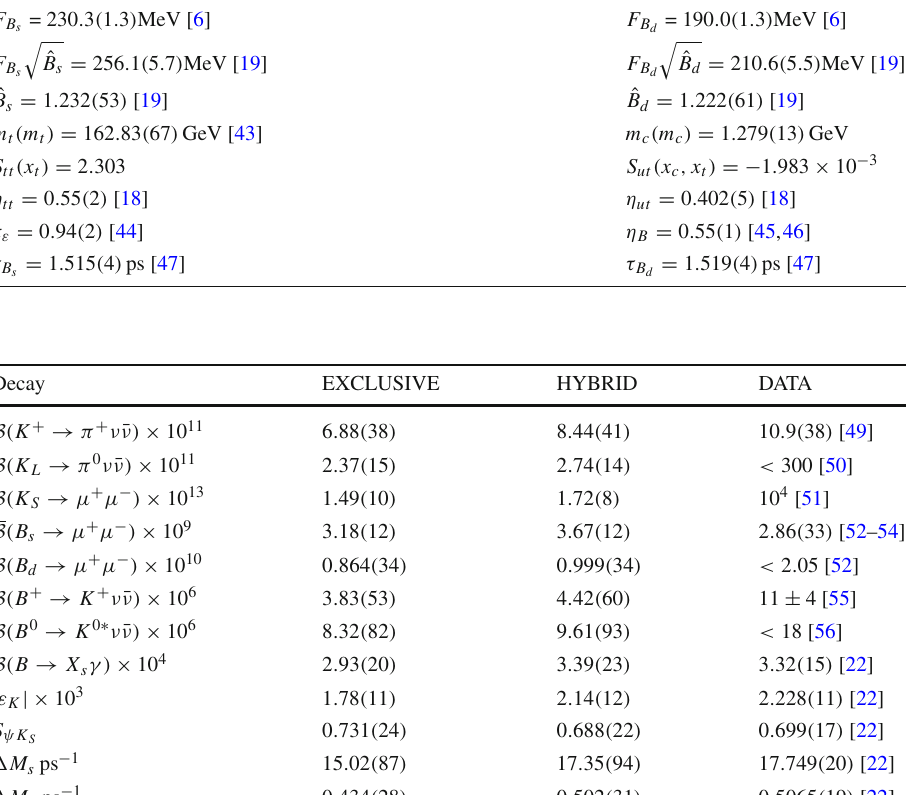
experimental and theoretical quantities used as input parameters. For future updates see FLAG [6], PDG [22] and HFLAV [42]